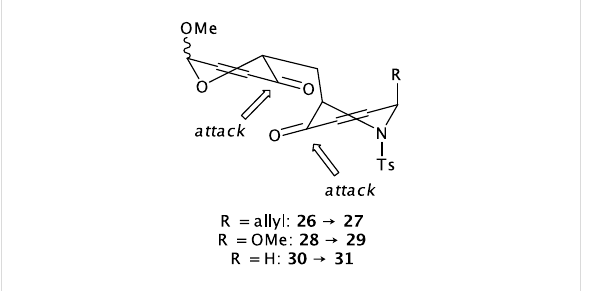
of the heteroatoms ( N -tosyl and O ) control the reactive conformation of the heterocycles. The more sterically demanding N -tosyl group forces the piperidone rings to